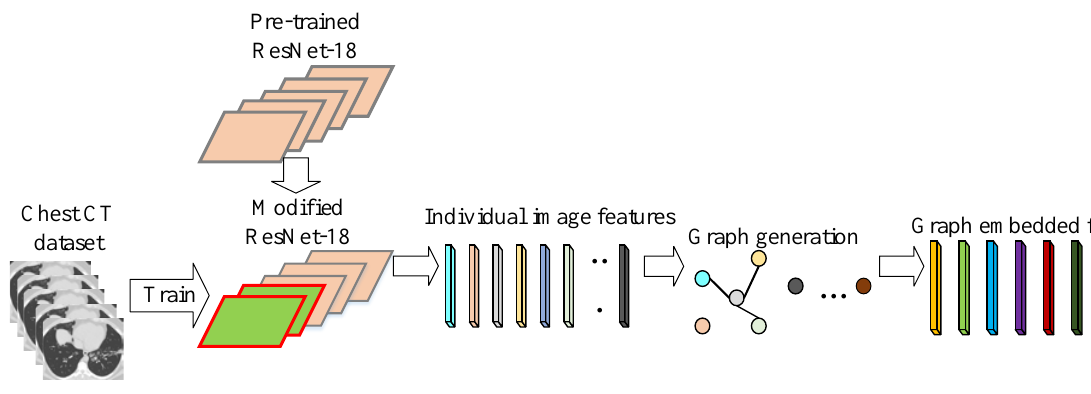
Figure 3. Flowchart of the graph embedding.